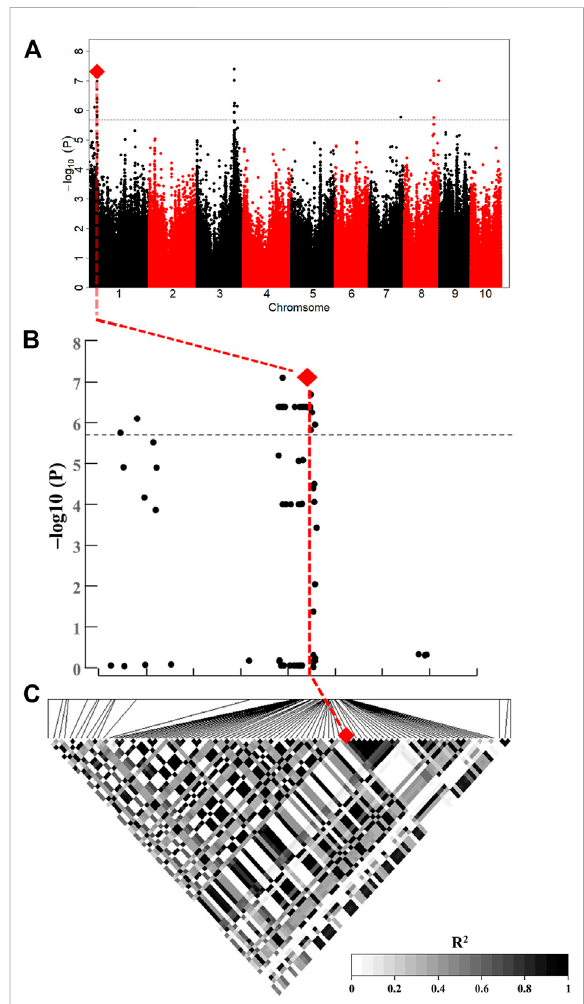
FIGURE 5 ZmULA1 affected LA-related traits. (A) Manhattan plot of ULA atHB.Thelinerepresentsthethreshold − log 10 (P) ≥ 5.69( p ≤ 2.04× 10 – 6 ). (B) Enlarged Manhattan plot of the lead SNP and 85 SNPs associated with ZmULA1 ; red diamonds represent the lead SNP. (C) R 2 values of signi fi cant SNPs associated with ZmULA1 ; the lead SNP was located in 2.64 kb downstream of ZmULA1